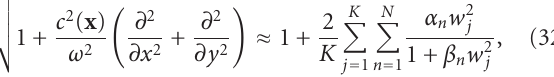
system of size n x × n y , the cascaded solution of (31)